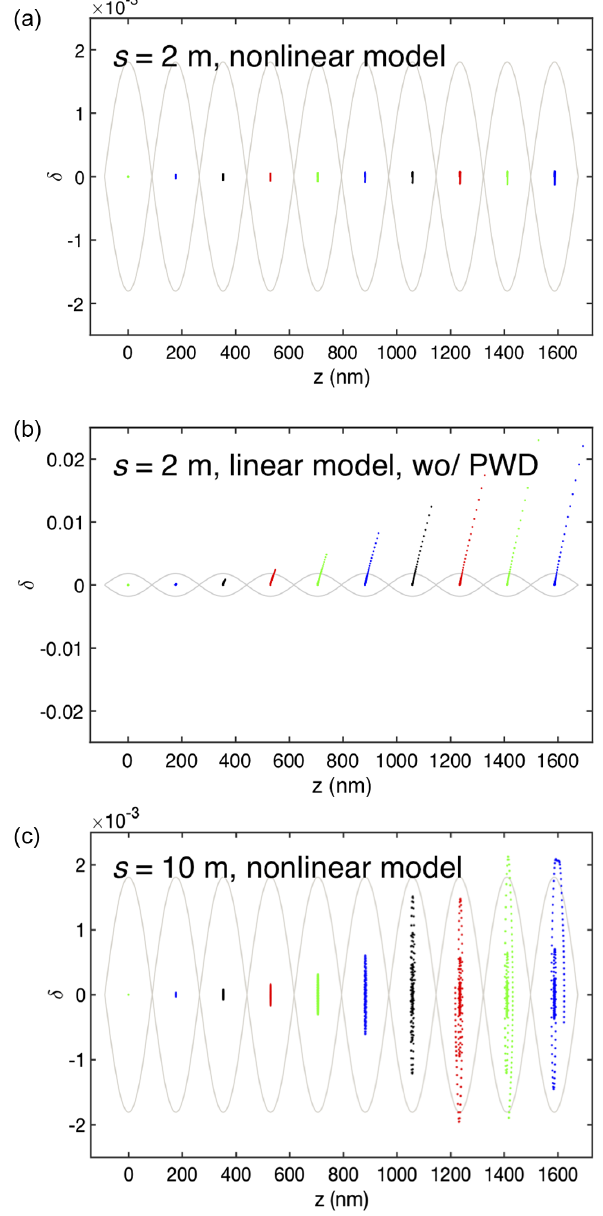
FIG. 8. Macroparticle phase space evolution for individual microbunches (a) at s ¼ 2 m based on the nonlinear model [Eq. (17)]; (b) at s ¼ 2 m based on the linear model [Eq. (21)] and neglecting potential-well term; (c) at s ¼ 10 m based on the ¼ 13 . For (c), the modulator voltage nonlinear model. Here H max is adjusted to retain the same laser field as that for